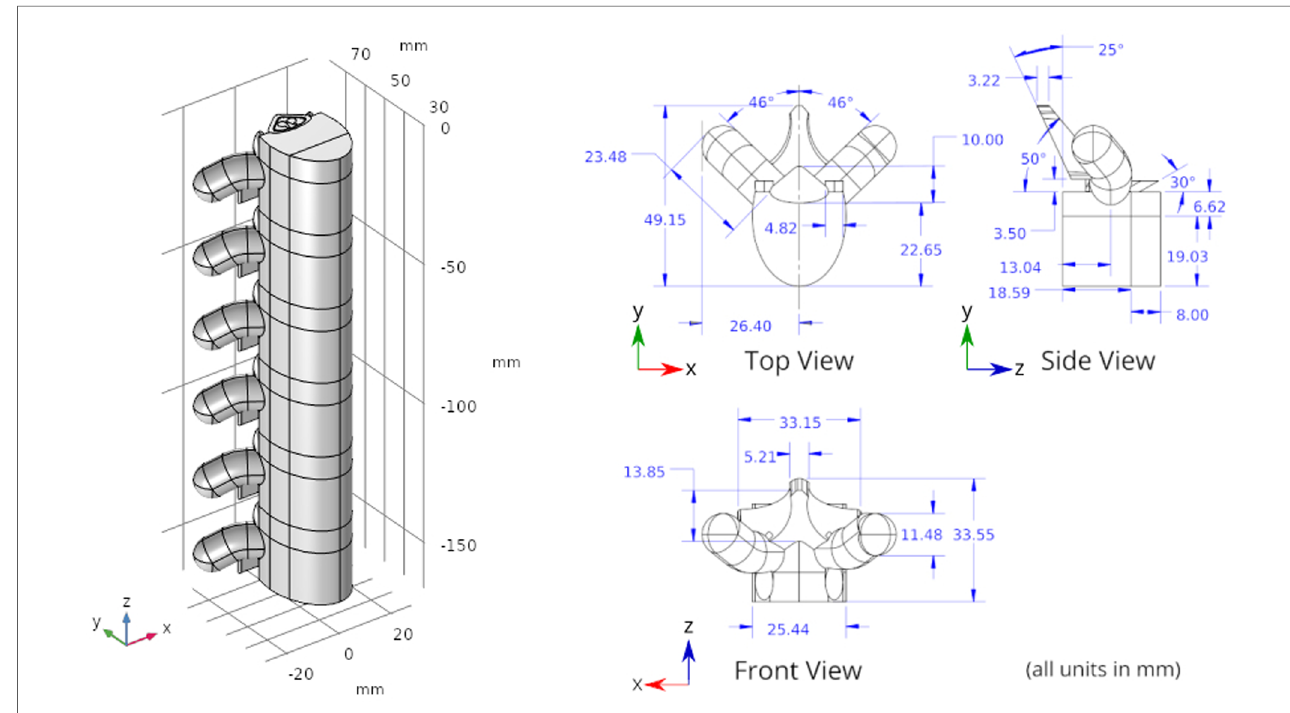
FIGURE 2 Spine geometry. The Z axis is aligned along the spinal cord. The XY plane is the transverse plane perpendicular to the spinal cord.